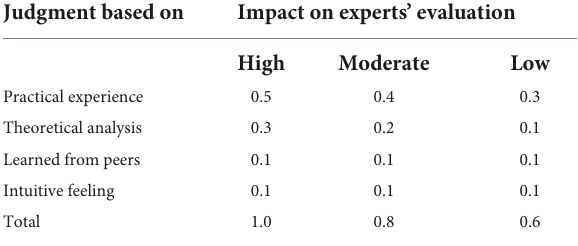
TABLE 2 Calculated expert judgment used in authority coefficient. Judgment based